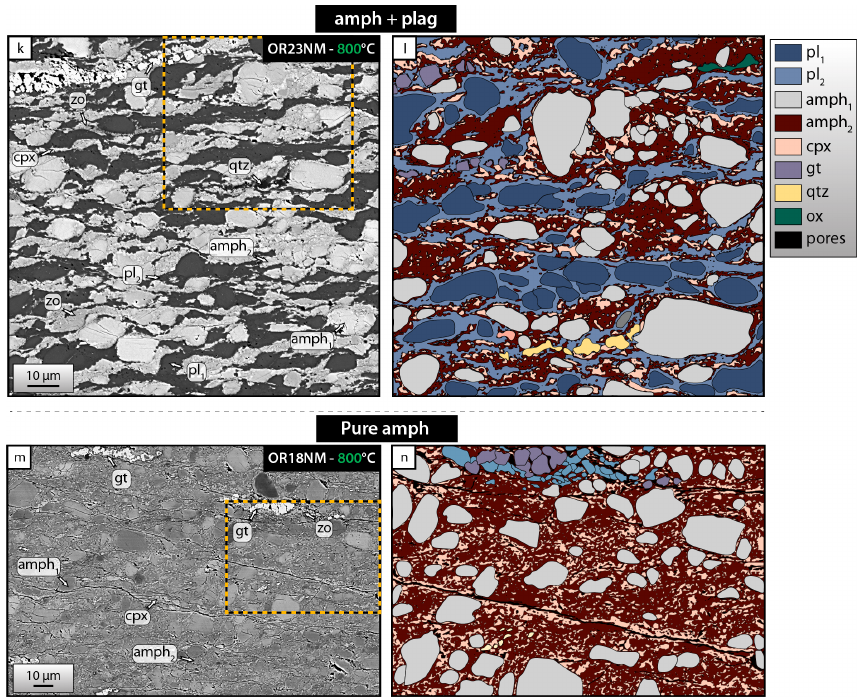
Figure 5. SEM BSE images representative of the different small-scale microstructures encountered in the assemblages and their respective manually digitized phase maps. Please note that the resolution is too low to resolve the full extent of phase mixing. opx: orthopyroxene, cpx: clinopyroxene, pl: plagioclase, amph: amphibole, qtz: quartz, gt: garnet, zo: